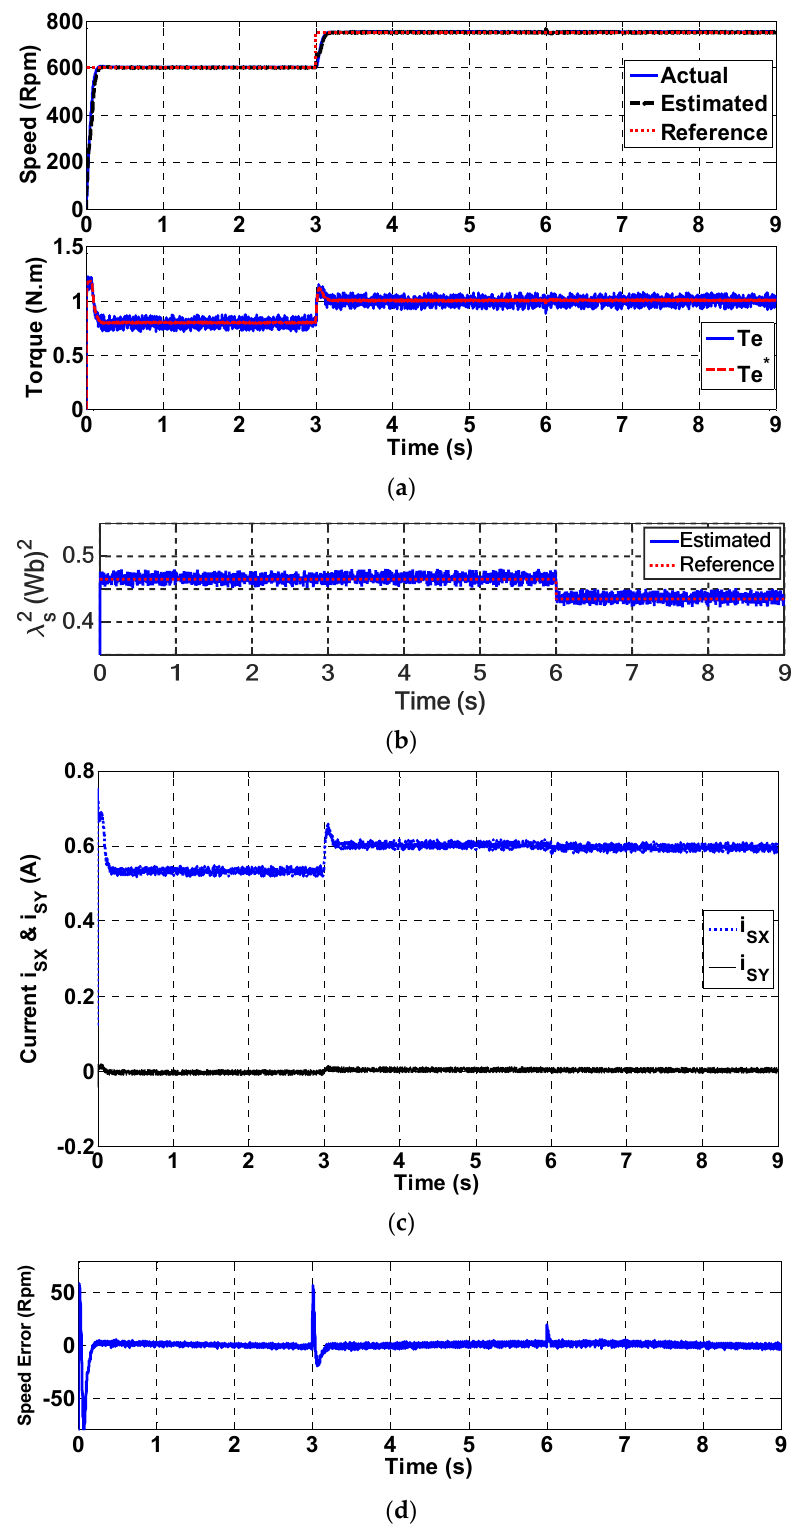
Figure 7. Experimental results of IPMSM drive: ( a ) torque and speed, ( b ) square of stator flux, ( c ) X - and Y -axis component currents, ( d ) error of speed.